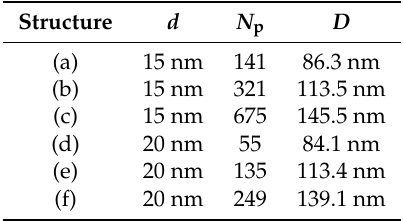
Table 1. Mesocrystalline particles